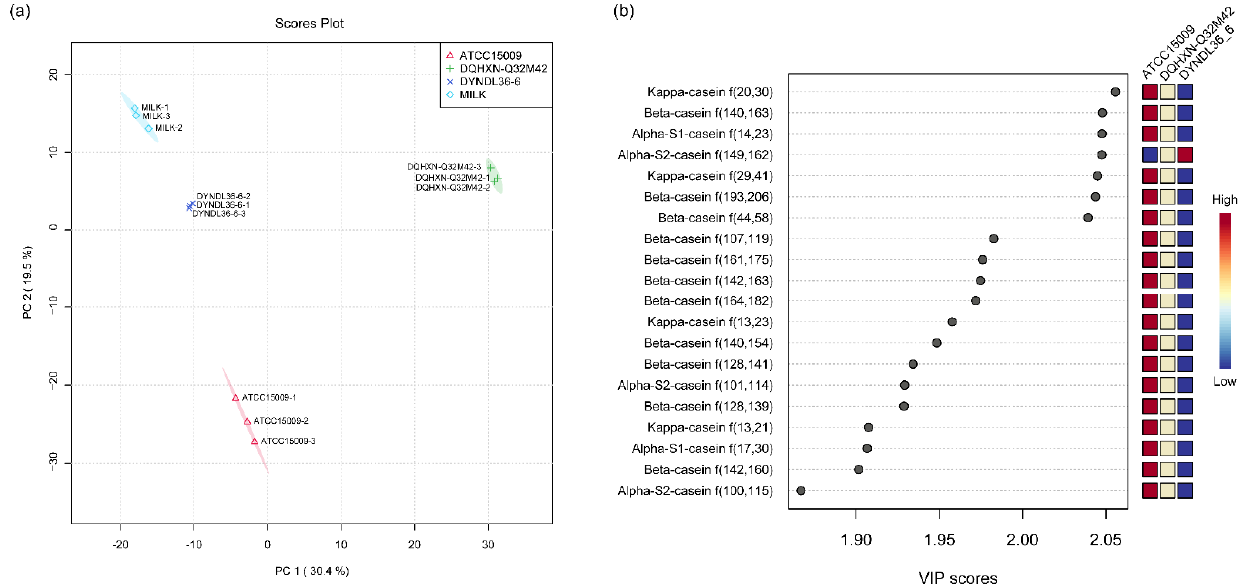
Figure 1. ( a ) Principal component analysis for peptidomics of fermented milks by Lactobacillus helveticus . ( b ) Peptides with the top 20 variable importance in projection (VIP) scores in the fermented milk of L. helveticus according to partial least ‐ squares discriminant analysis.